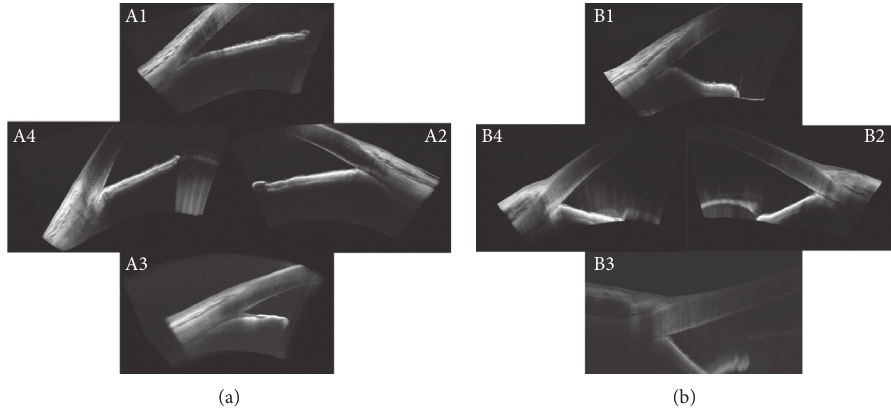
Figure 4: Anterior chamber angle OCTimages of an NVG patient before and after the combined surgery. A1–A4, baseline images showing complete angle closure. B1–B4, the same eye, 10 months after surgery, showing that the angle remains closed. Images A1/B1, A2/B2, A3/B3, and A4/B4 represent 12, 3, 6, and 9 o’clock, respectively.